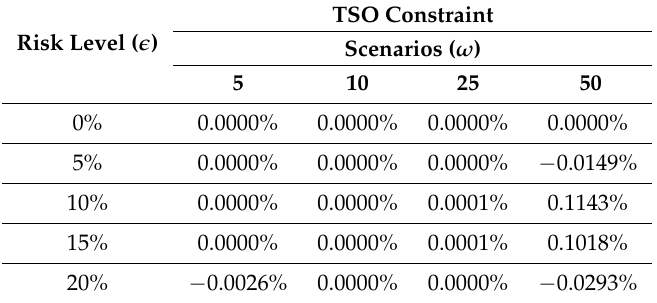
Table 1. Expected profit differences between McCormick and Big-M methods applied to the TSO balance constraint in percentage